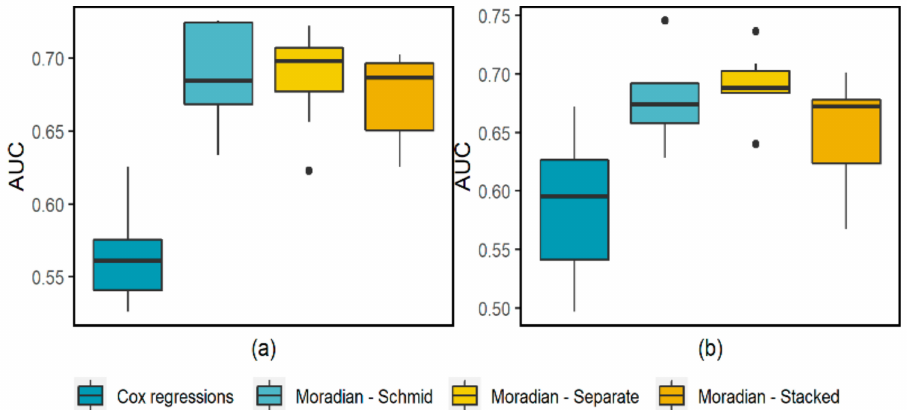
Figure 5. AUC comparison of simulated Cox regressions and random forests (N = 500) when t = 4: